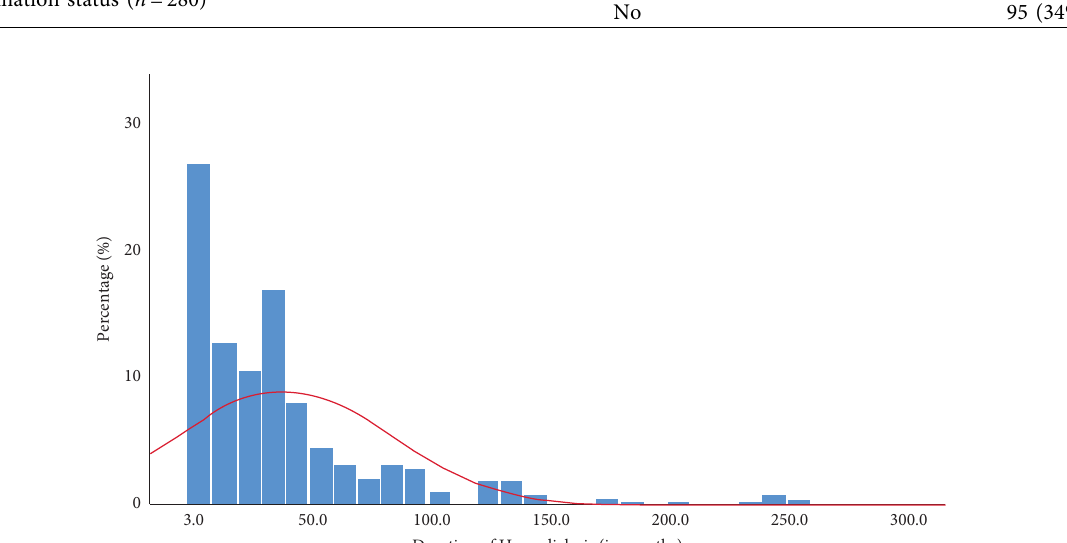
Figure 3: Graphical representation of the frequency of months on dialysis among our HD study patients.